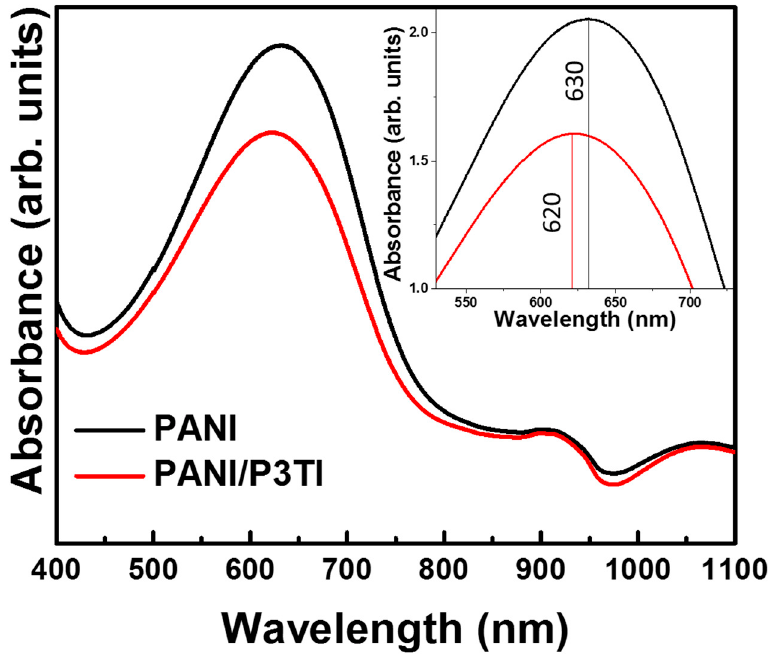
Figure 1. Absorbance spectra of PANI and PANI/P3TI.